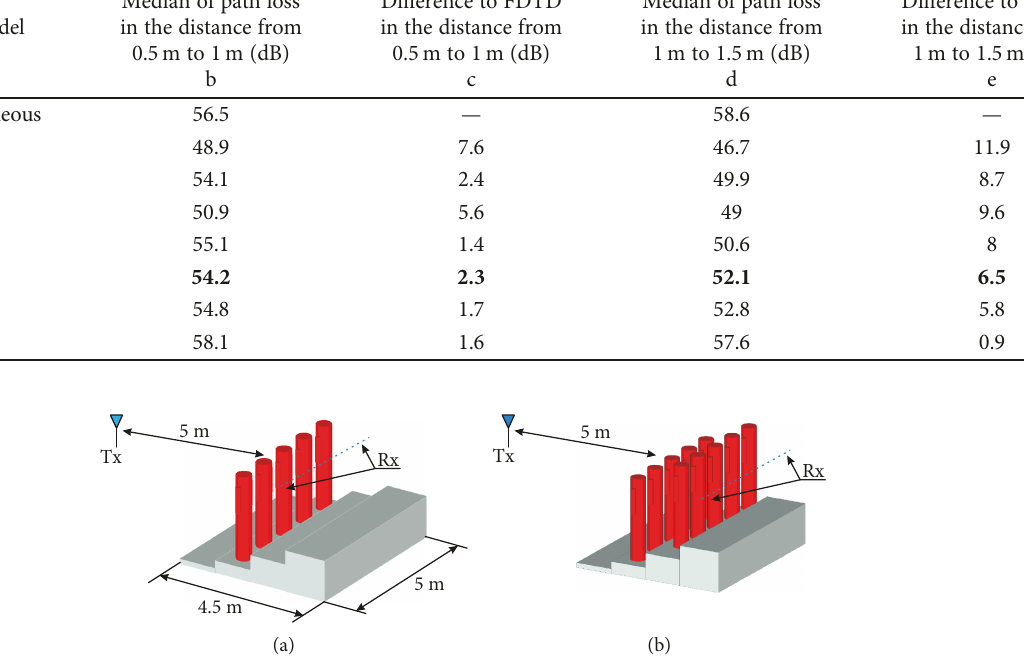
Table 2: Median values of path loss obtained for di ff erent geometries of models — body orientation 2. Human body